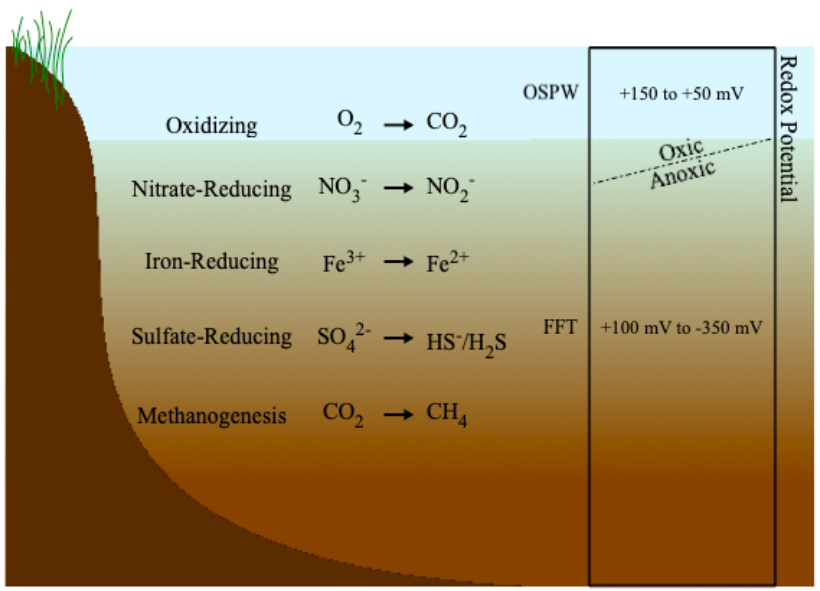
Figure 2. Redox profile for tailings landforms and redox potential ranges for cap water and tailings deposits.